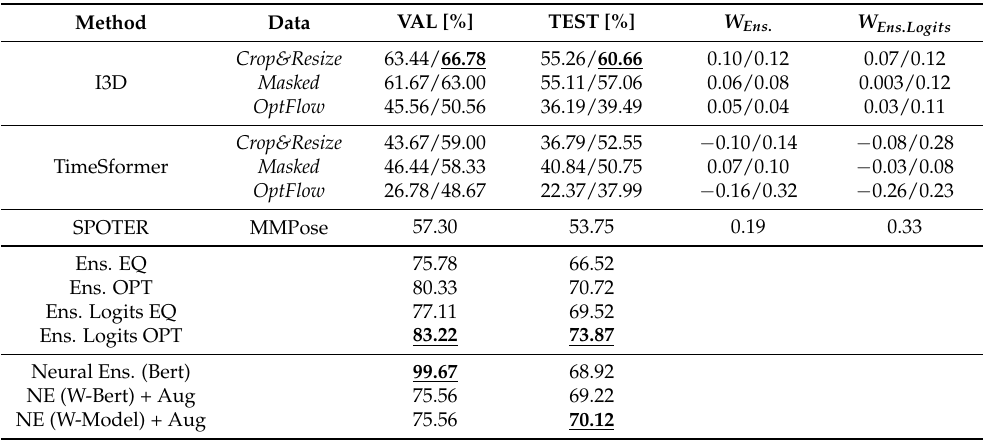
Table 4. WLASL300 results. Only MMPose is used during the preprocessing step. When we used the fine-tuned models, the results are reported as (WLASL only/AUTSL pretrain). W Ens . and W Ens . Logits = weights of individual models in the CMA-ES